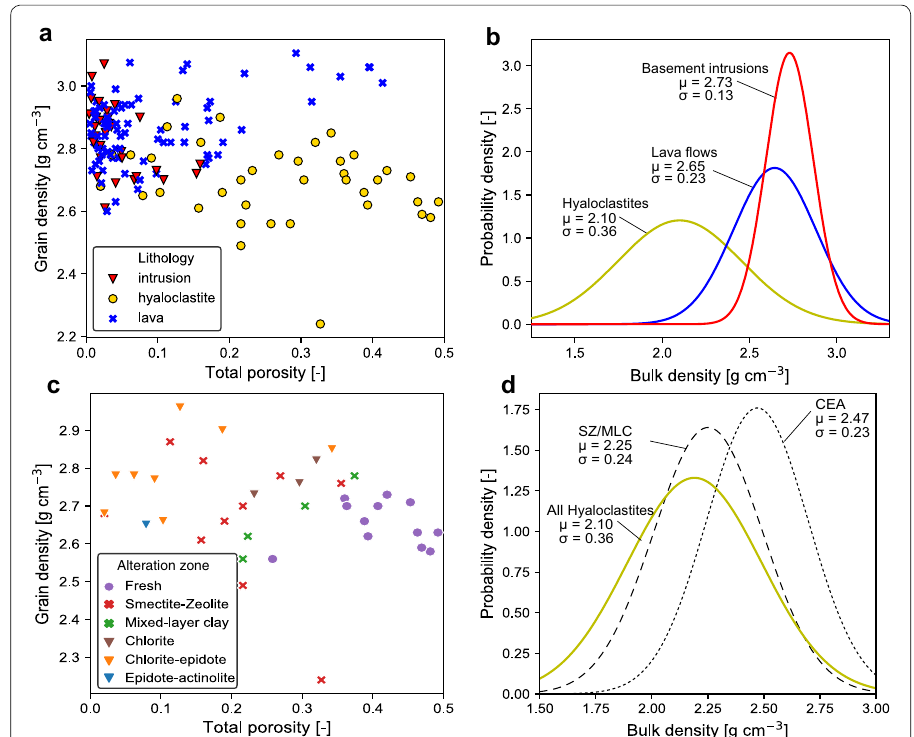
Fig. 4 Rock property data used to constrain prior pdfs. a Measured data for grain density and total porosity, sorted by lithology. b Prior probability distribution functions (pdfs) for bulk density. c Measured data for grain density and total porosity of hyaloclastite, sorted by alteration zone. d Prior pdfs for hyaloclastite bulk density calculated for alteration zones. SZ/MLC indicates pdf for smectite–zeolite and mixed-layer clay zones,